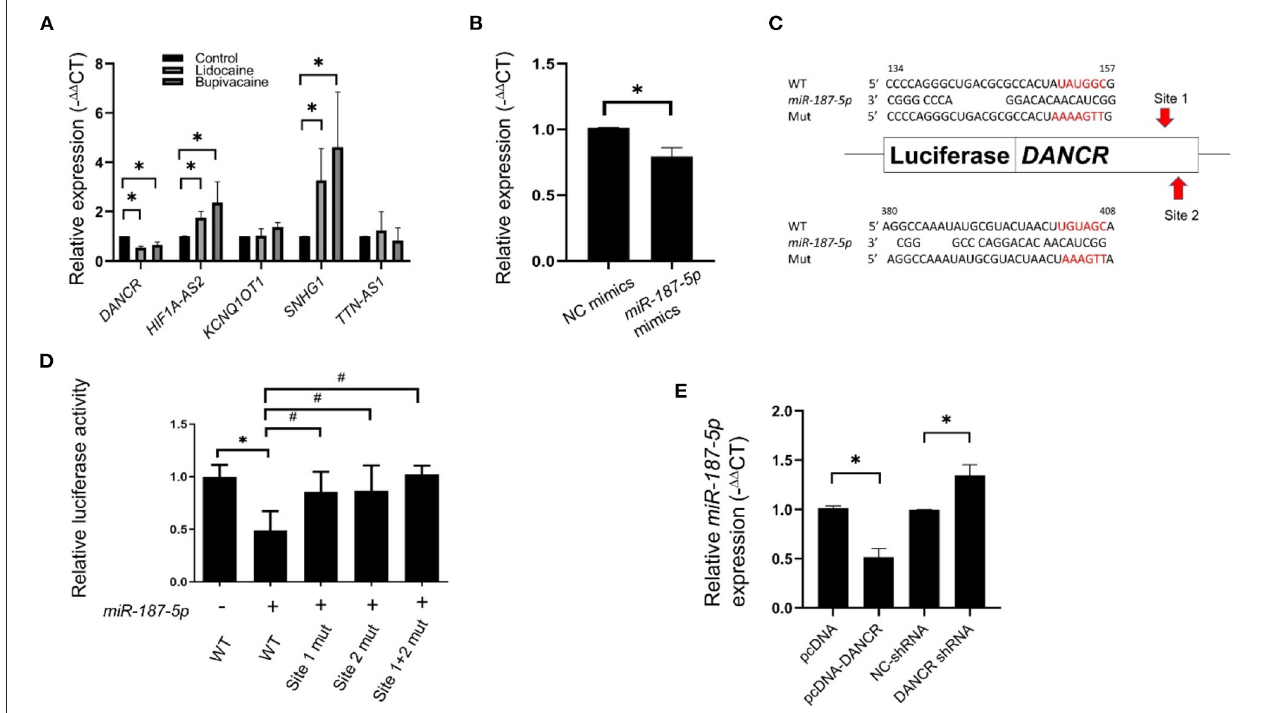
FIGURE 4 | Expression of DANCR lncRNA was downregulated in MCF-7 cells following treatment with lidocaine or bupivacaine. (A) The relative expression levels of selective lncRNAs in MCF-7 cells following treatment with lidocaine (4mM) or bupivacaine (1mM). The expression levels were measured using qRT-PCR and normalised to that of 18S rRNA. (B) Relative expression levels of DANCR in MCF-7 cells overexpressing miR-187-5p . The cells were transfected with 2 µ g of miR-187-5p or control mimics. The expression levels were detected using qRT-PCR and normalised to that of 18S rRNA. (C) Schematic diagram of the putative binding site of miR-187-5p in the binding region of DANCR . (D) Luciferase reporter assays of DANCR in HEK-293T cells overexpressing miR-187-5p . The HEK-293T cells were transfected with miR-187-5p mimics, firefly luciferase plasmids, and Renilla luciferase vectors. The relative activity of firefly luciferase was measured and normalised to that of Renilla luciferase. (E) The relative expression levels of miR-187-5p in MCF-7 cells overexpressing DANCR or shRNAs against DANCR . The expression levels were detected using qRT-PCR and normalised to that of U6 snRNA. The data are presented as mean ± SD ( n = 3). * p < 0.05.